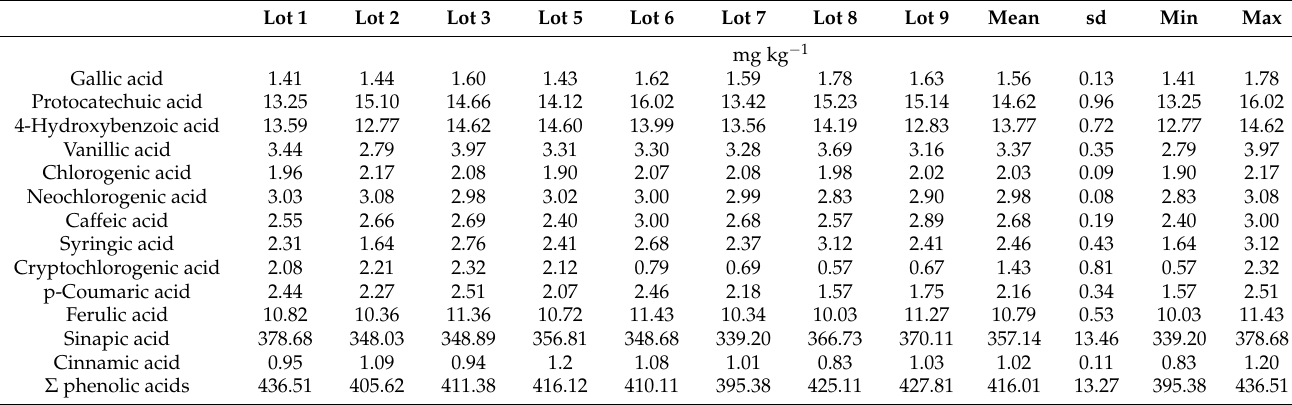
Table 3. Concentration of phenolic acids in rapeseed meal samples and sum of all detected phenolic compounds (mg kg − 1 product). Mean, standard deviation, and range of values obtained from different lots collected between July 2018 and July 2019 ( n = 8)